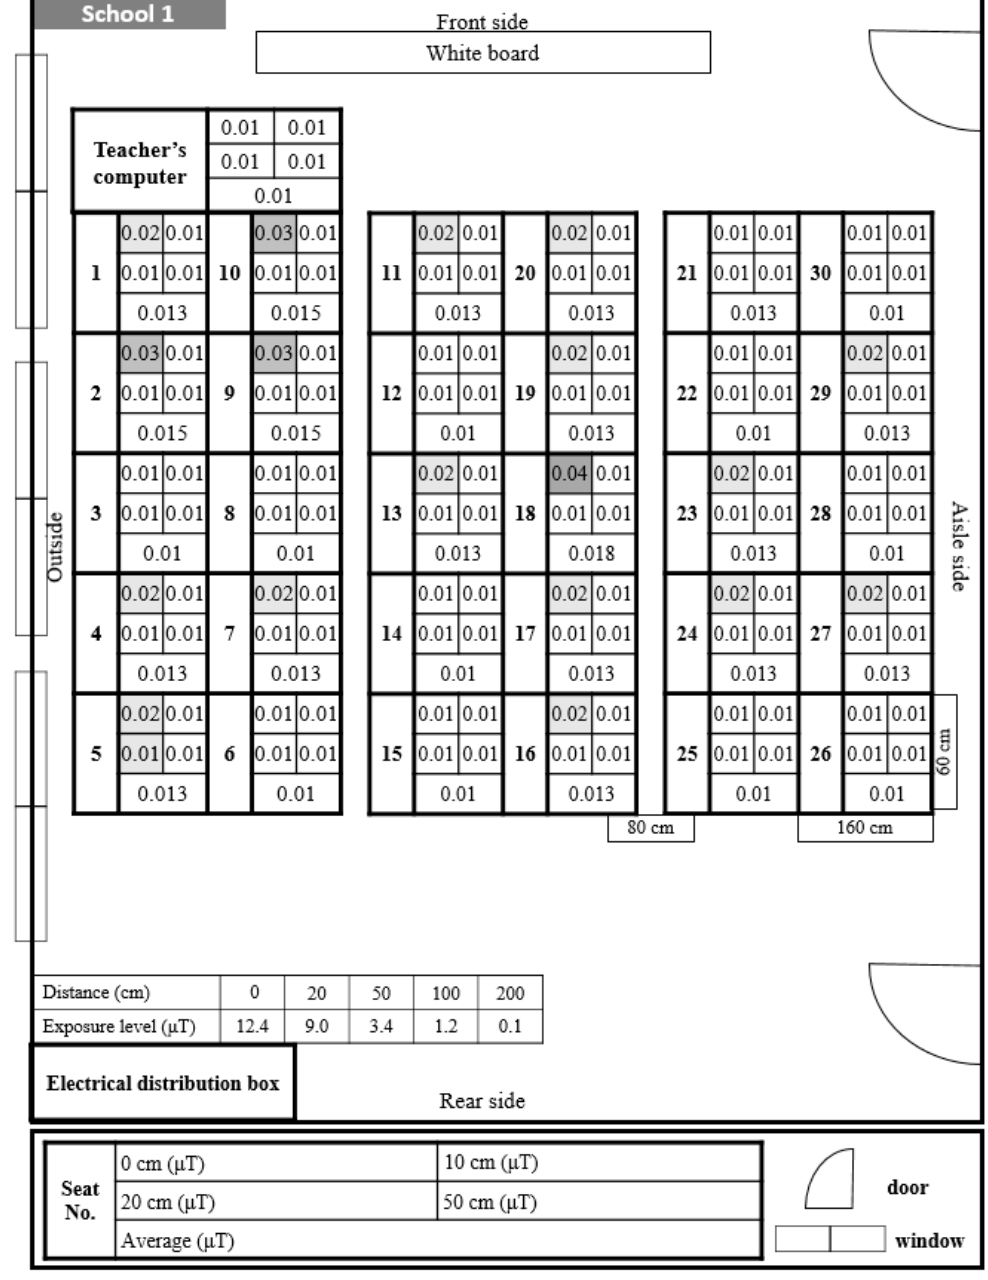
Figure 2. Distribution and exposure level of extremely low-frequency magnetic fields at each student seat in School 1. 0.01 is the lowest readout level, indicating < 0.01. The darkening of the space indicates that the level of ELF-MFs exposure increase by 0.01.